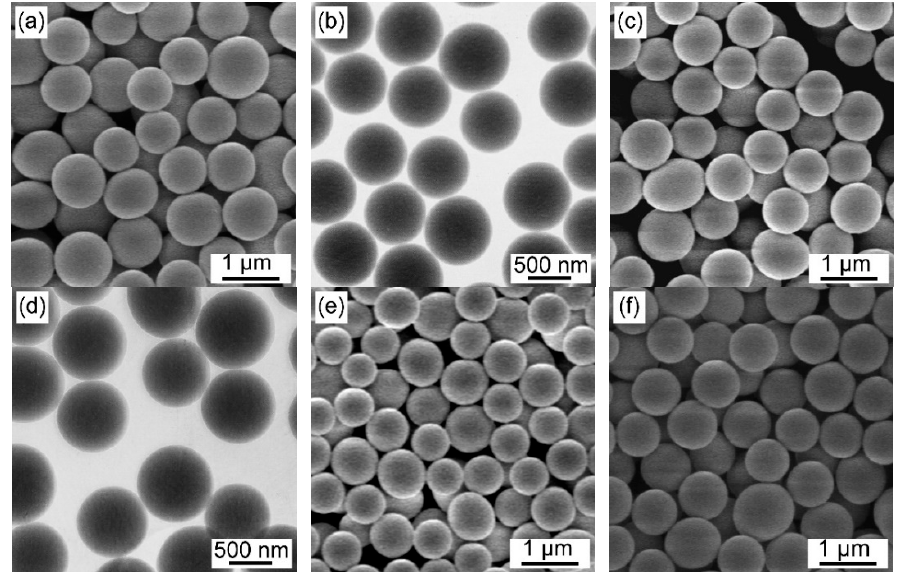
Figure 2. Field emission scanning electron microscopy (FESEM) images of the particles prepared using ( a ) wheat, ( c ) corn, ( e ) starch and ( f ) maltose. Transmission electron microscopy (TEM) photographs of the samples synthesized from ( b ) wheat and ( d ) corn.